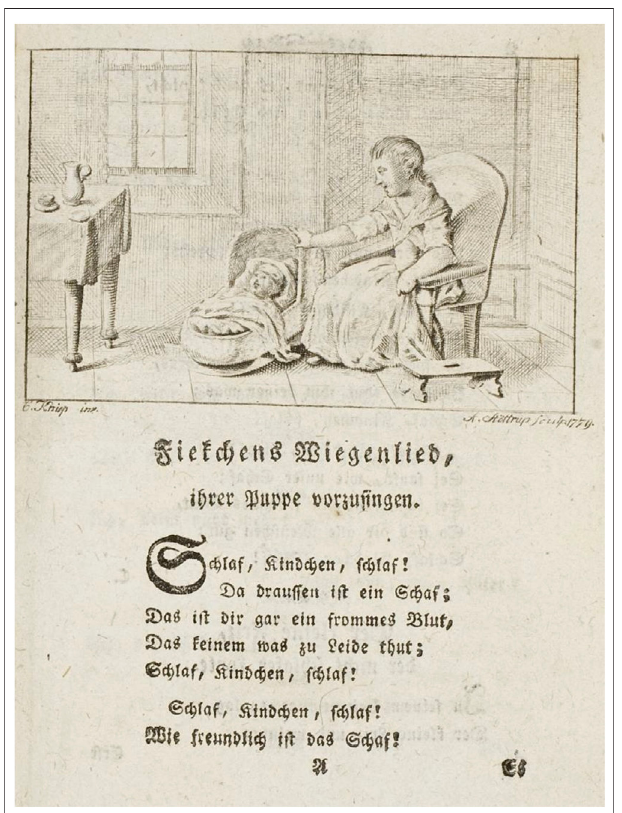
FIGURE 5 | Campe, “ Fiekchens Wiegenlied, ihrer Puppe vorzusingen, ” from Kleine Kinderbibliothek (1779:2, 1). Courtesy of SUB Göttingen, shelfmark DD ZA 246:2.